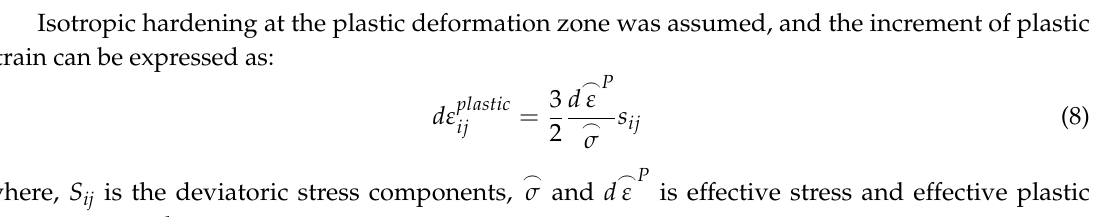
Figure 5. Mechanical properties of Q235 as a function of temperature.